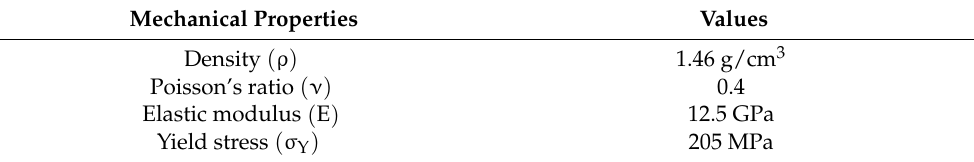
Table 6. Mechanical properties of